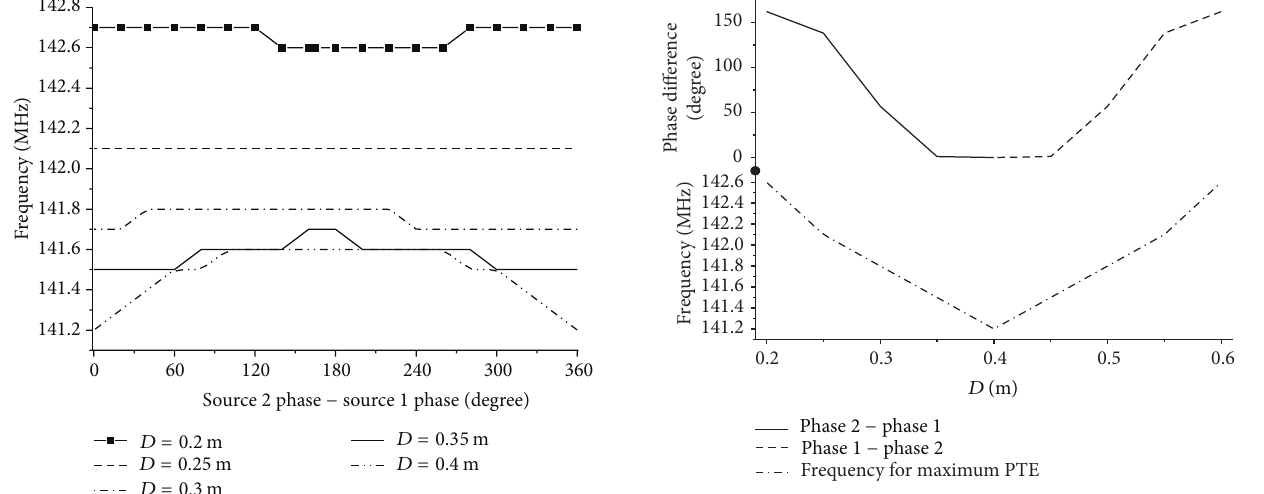
Figure 13: Optimum phase difference and frequency for maximum efficiency PTE mat against separation 𝐷 .